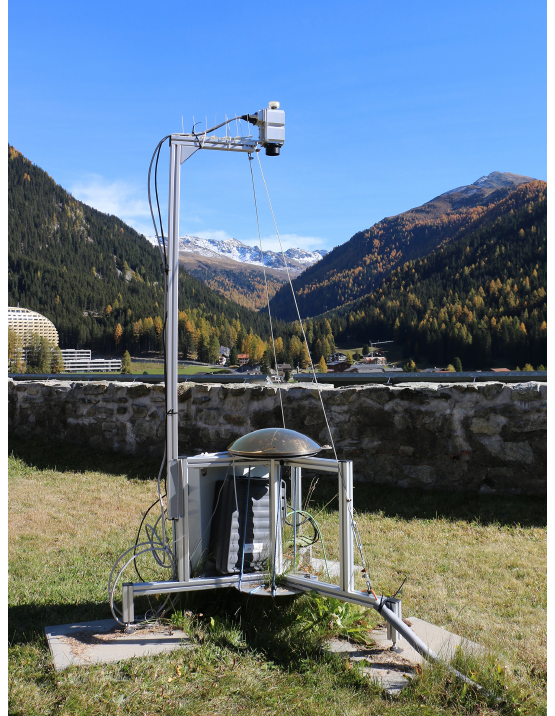
Figure 1. The infrared cloud camera (IRCCAM) in the measure- ment enclosure of PMOD/WRC in Davos, Switzerland.